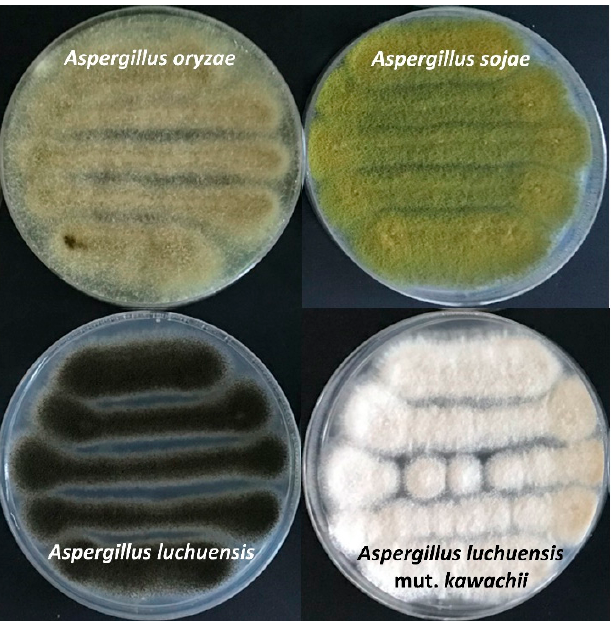
Figure 1. Plate culture images of A. oryzae , A. sojae , A. luchuensis and A. kawachii . Spores of Koji molds are called Koji starter, and these cultures on cereals and crops are used for fermented foods in industries. Yamashita has outlined the historical back- grounds of Koji starter and Koji , explained these varieties for preparations of fermented foods, and proposed potential uses in the future [1]. One of the fermented beverages produced by using A. oryzae is amazake , the Japanese traditional sweet drink. Kurahashi has provided the information from recent research about ingredients and functionality of amazake [2]. In addition, Kurahashi et al. have reported the latest research data about the improvement of defecation frequency by taking Koji amazake [3]. Shochu and awamori , the Japanese traditional distilled liquors, are made by using A. kawachii and A. luchuensis